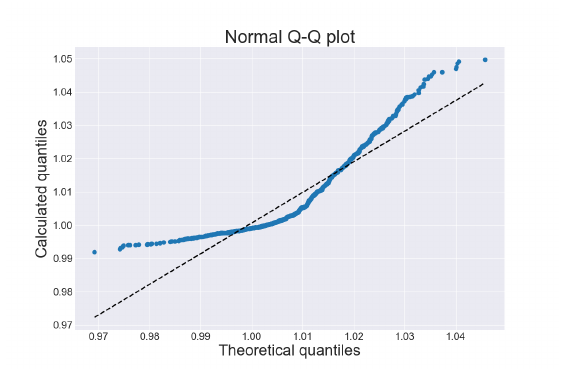
Figure 5: Quantile-quantile plot (Q-Q plot) of k e ff produced with 300 perturbed P1 coe ffi - cients. The dashed line represents the Q-Q plot for a Normal